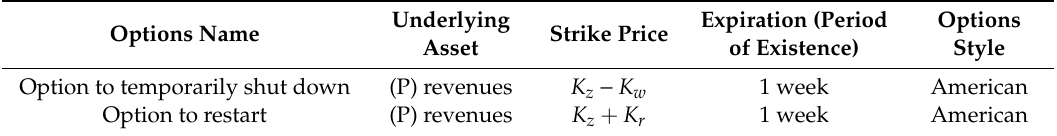
Table 1. Characteristics of real options used in the valuation model.